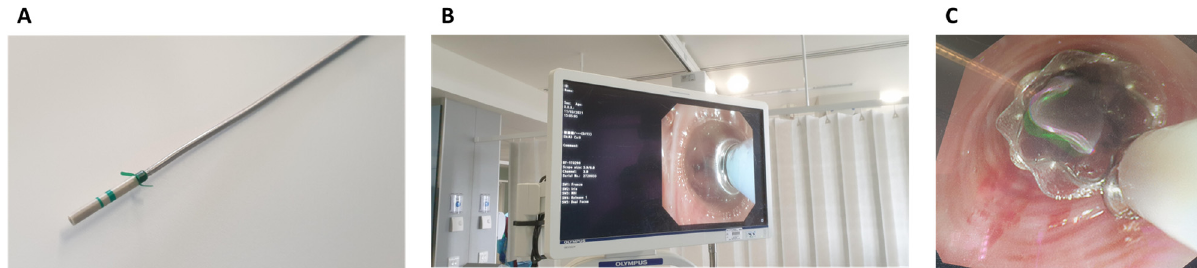
Figure 1. Endobronchial valve placement at the bedside in the intensive care unit. ( A ) Zephyr endobronchial valve prior to deployment; ( B ) selective endobronchial balloon occlusion in progress; and ( C ) endobronchial valve deployed in the airway.